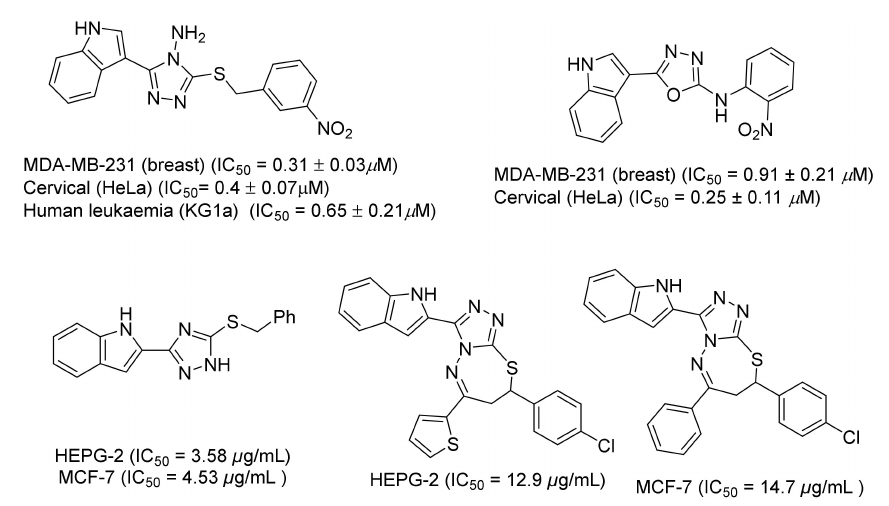
Figure 1. Selected 1,2,4-triazole- indole sca ff